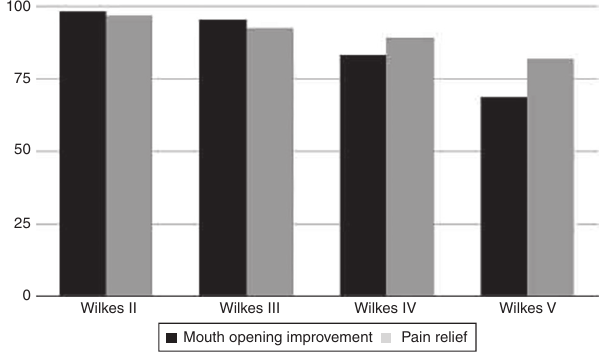
Figure 6 Relationship between means (in percentage) of mouth opening improvement and pain relief, compared to Wilkes stages found during TMJ